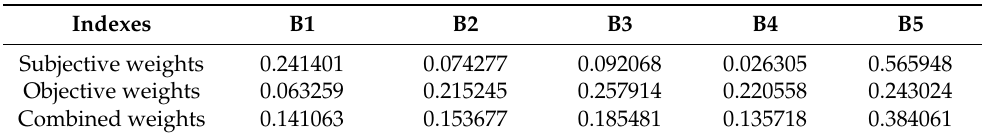
Table 19. Weight values of different